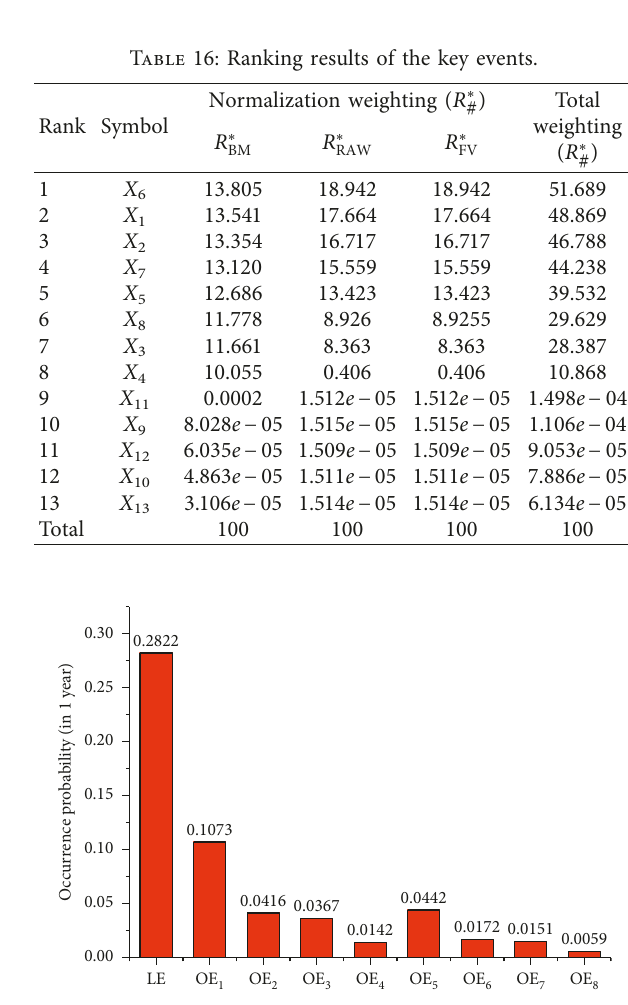
Figure 13: Occurrence probability when safety is ensured at key